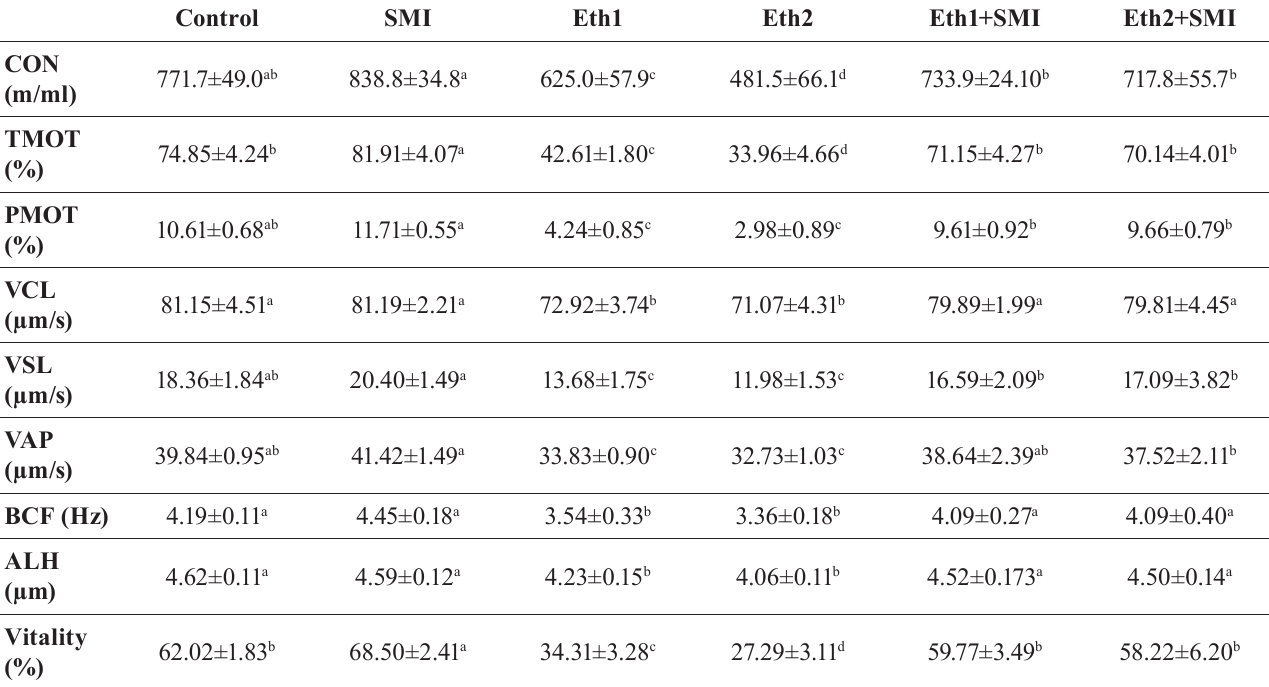
TABLE III - Values of spermatozoa biology parameters of Wistar rat expressed as mean± SD after six consecutive weeks of